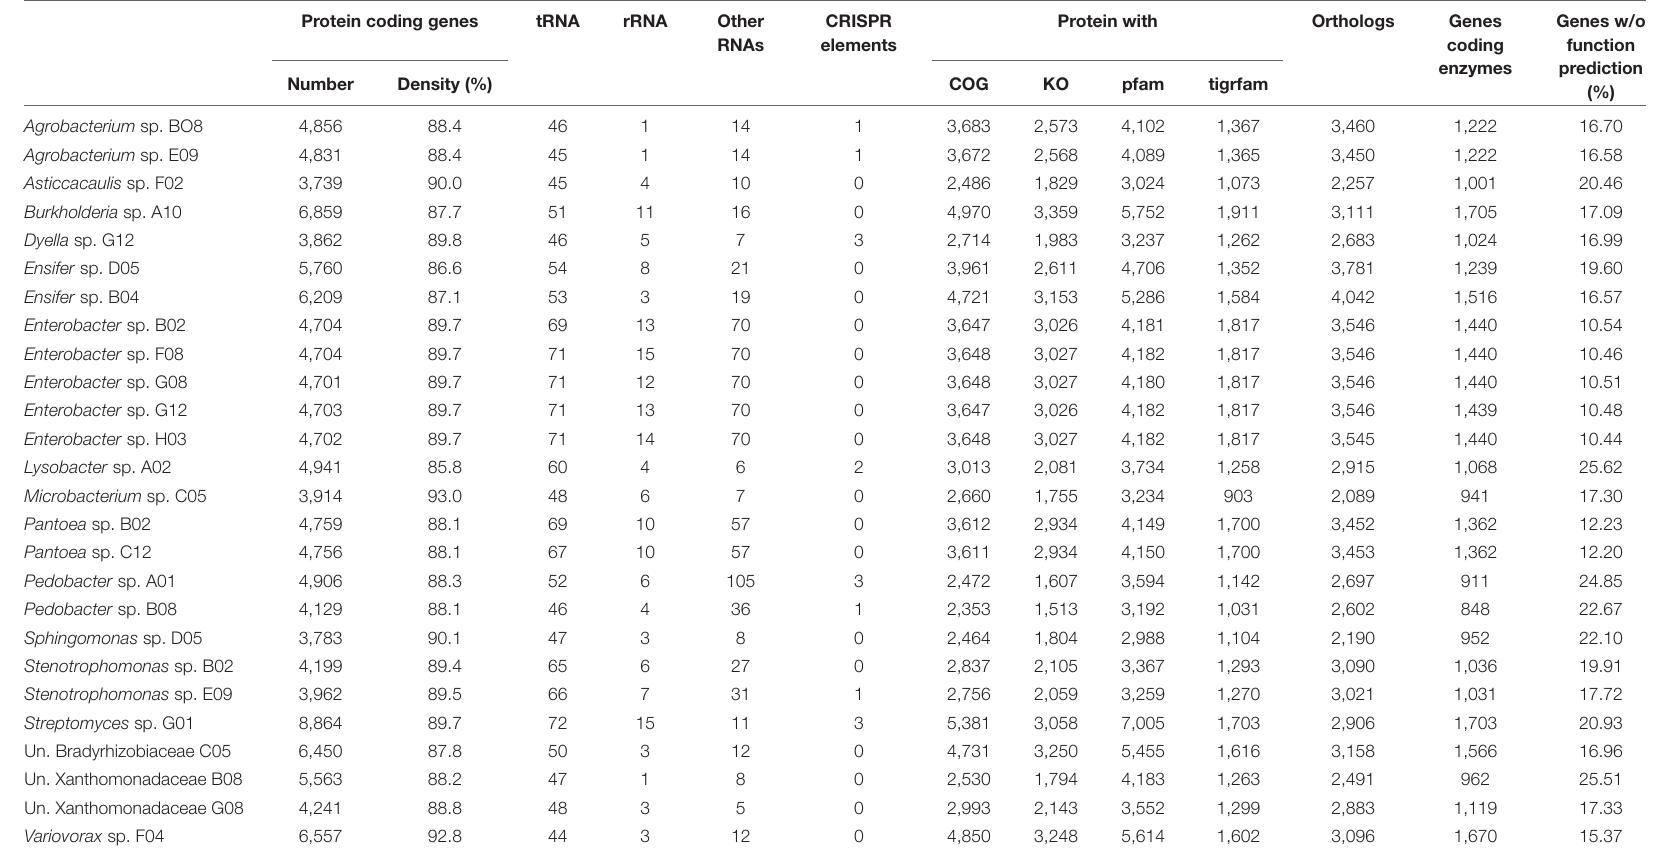
TABLE 2 | Structural and functional features of the 26 individual genomes of the SynCom.